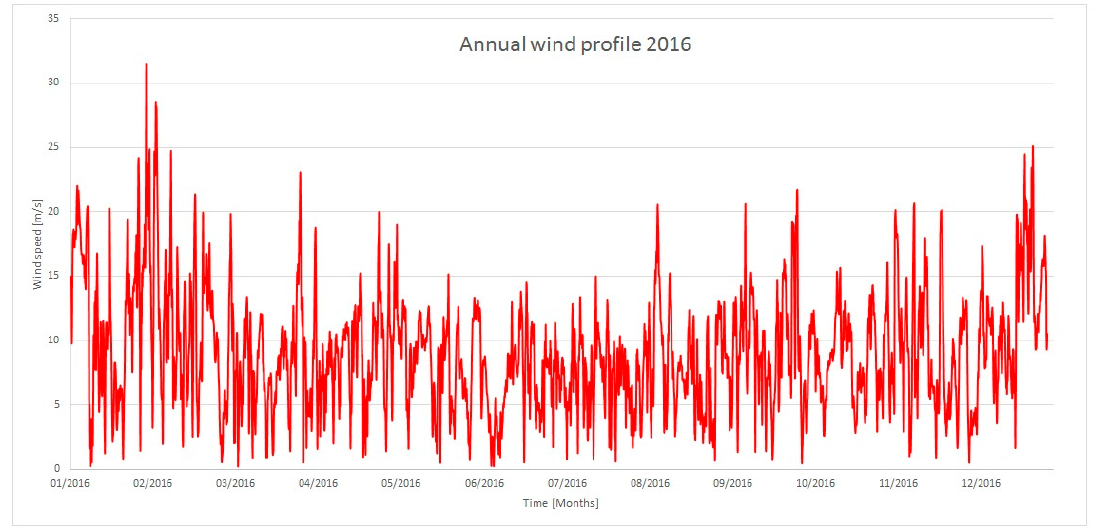
Figure 2. Wind speed profile of the year 2016.